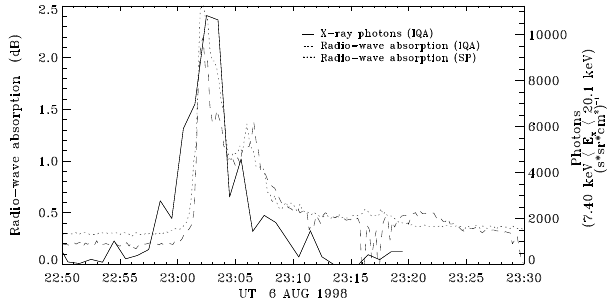
Fig. 9. Riometer data from the two conjugate stations (dashed line: Iqaluit, dotted line: South Pole) compared with X-rays (solid line) integrated in a circle of radius 570 km over Iqaluit. The riometer field-of-view is about 250 × 250 km and the data is averaged over all 49 beams to make a fair comparison with the spatial resolution of PIXIE